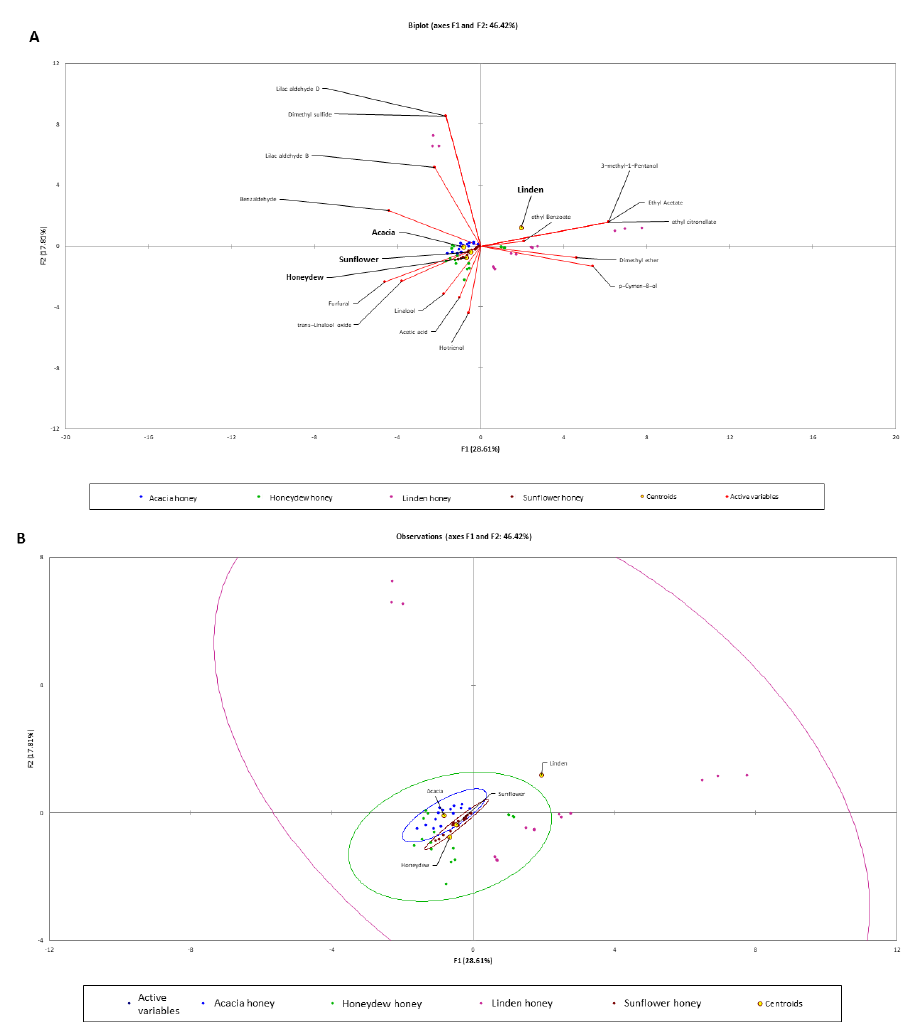
Figure 1. PCA evaluation of four kinds of honey (honeydew, acacia, linden, and sunflower); ( A )— significant (>5%) aroma profile of samples with corresponding aromas; ( B )—categorization of